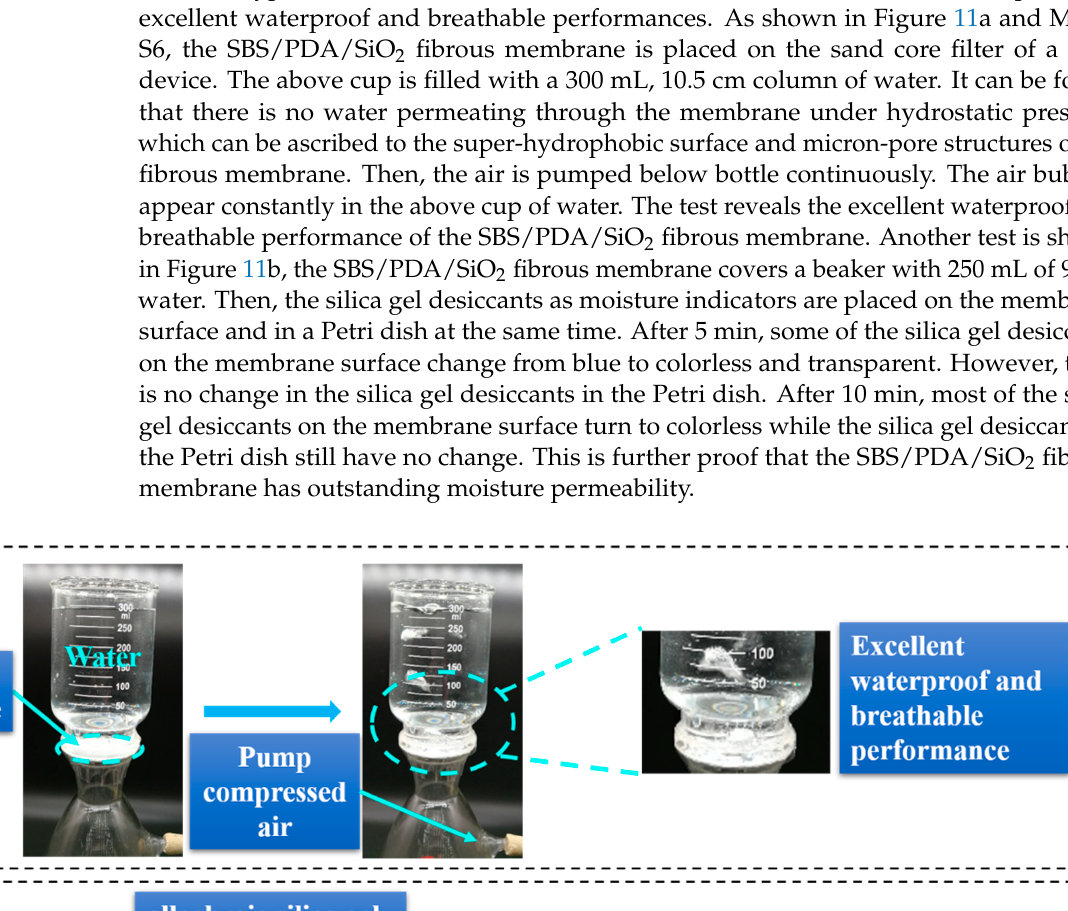
Figure 10. The SBS/PDA/SiO 2 fibrous membrane contaminated with CuSO 4 particles was washed cleanly with water.